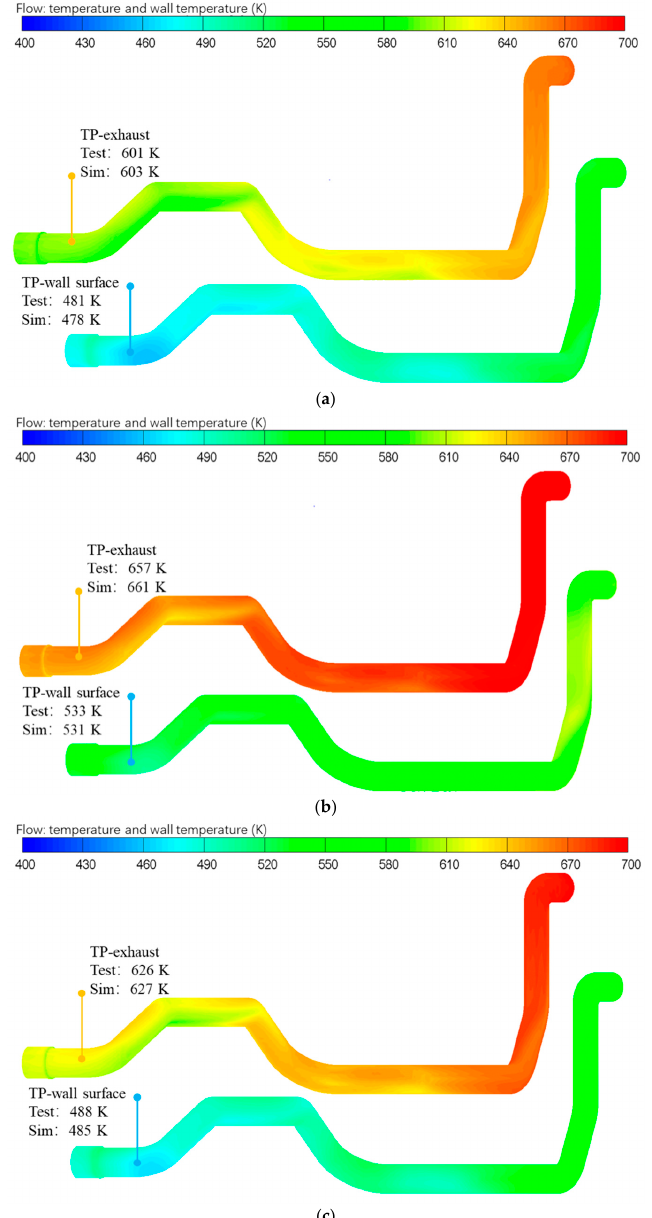
Figure 11. Simulation and experimental results of exhaust temperature and pipe wall temperature under typical operating conditions. ( a ) Case 1; ( b ) Case 2; ( c ) Case 3.